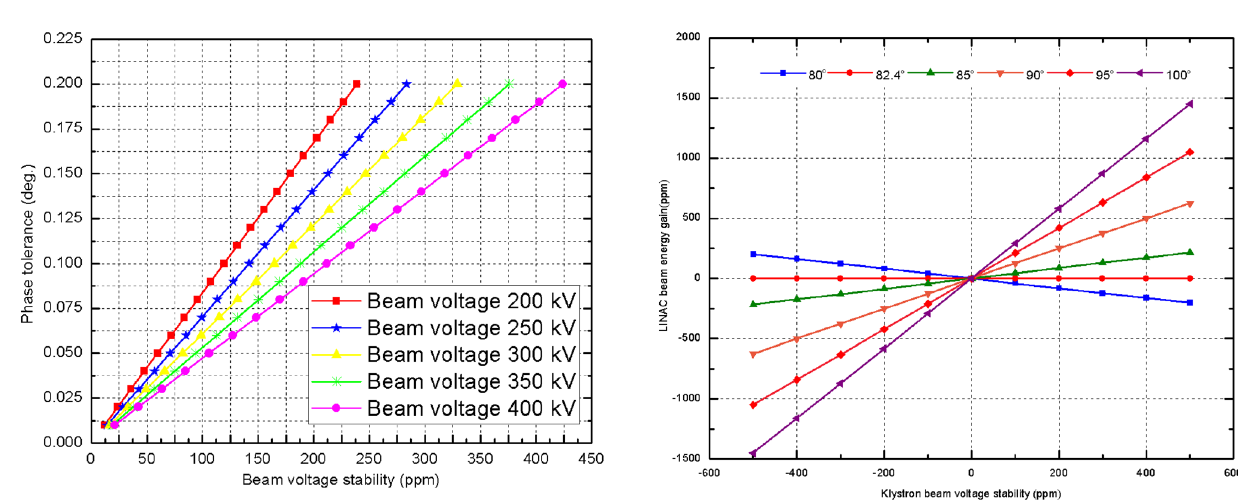
Fig. 7 The relationship between the electron beam energy and the stability of the modulator pulse under different